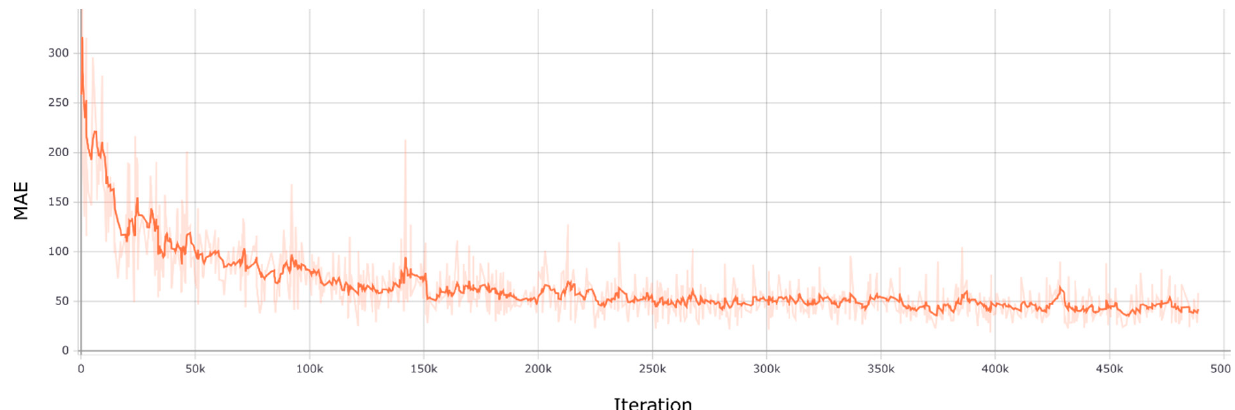
Figure 7. Loss function during training. The loss function used was the Mean Absolute Error (MAE) and the training was performed during 25 epochs (~500 k iterations).